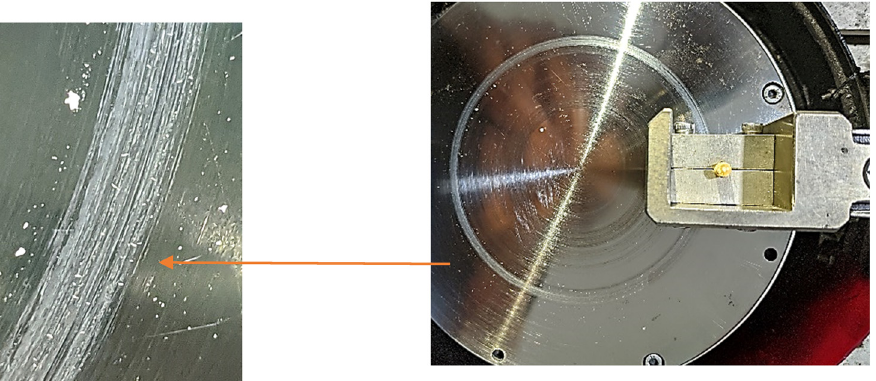
Figure 8: Transfer layer generation of the lubricating fi lm on steel disc during tribological testing of 2 wt% and 4 wt% h - BN - reinforced nylon 6 composites.